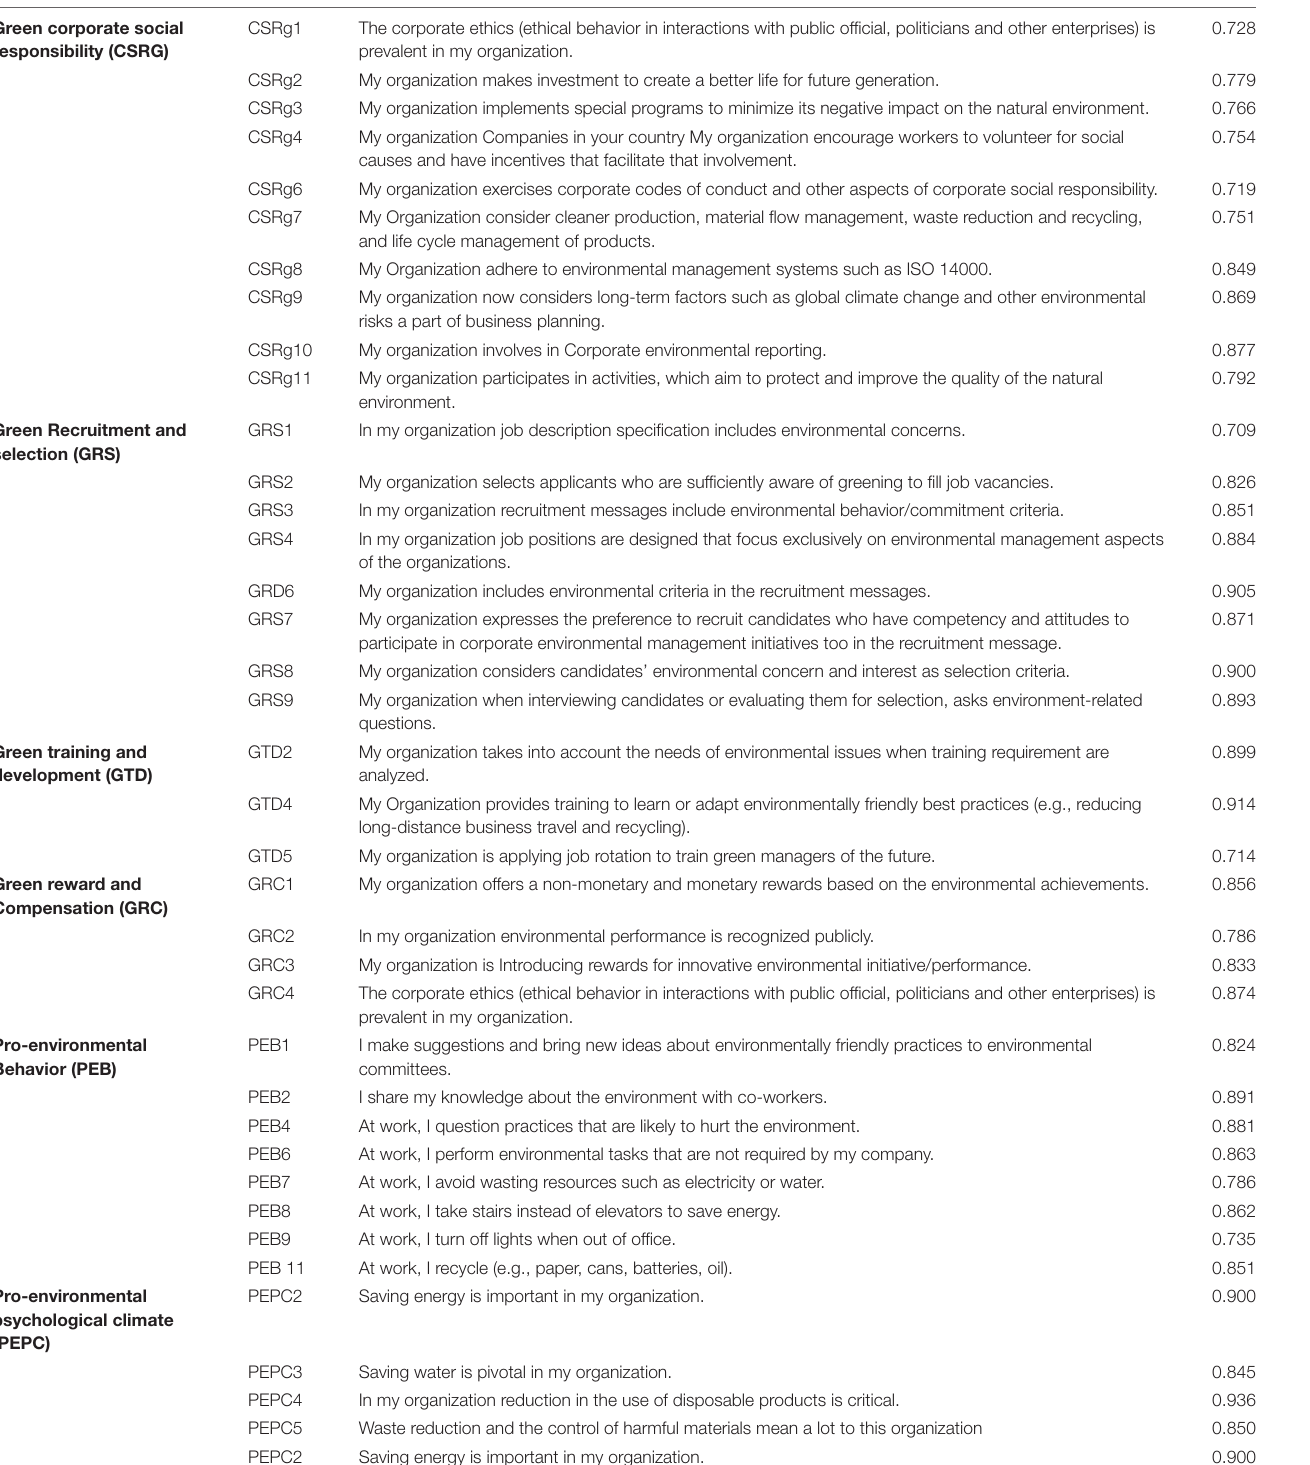
TABLE 4 | Factor loading of all